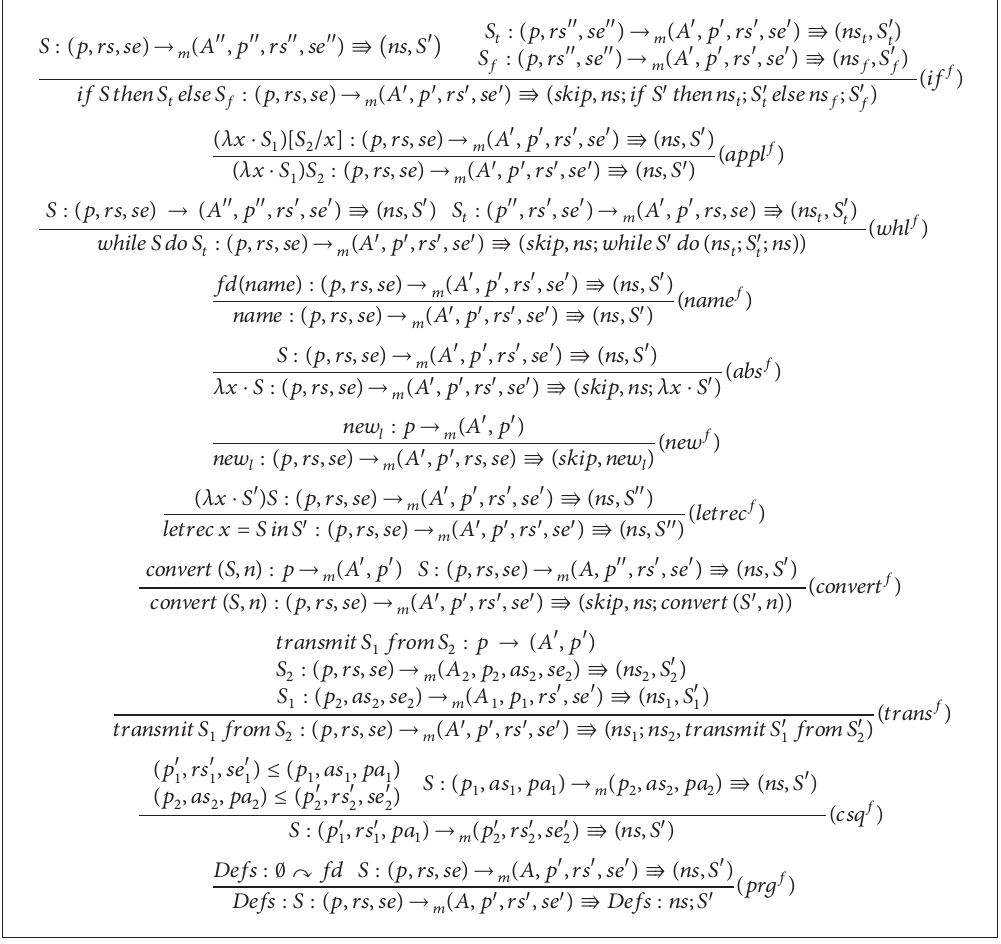
Algorithm 4: Inference rules for the frequent statements and dereferences elimination